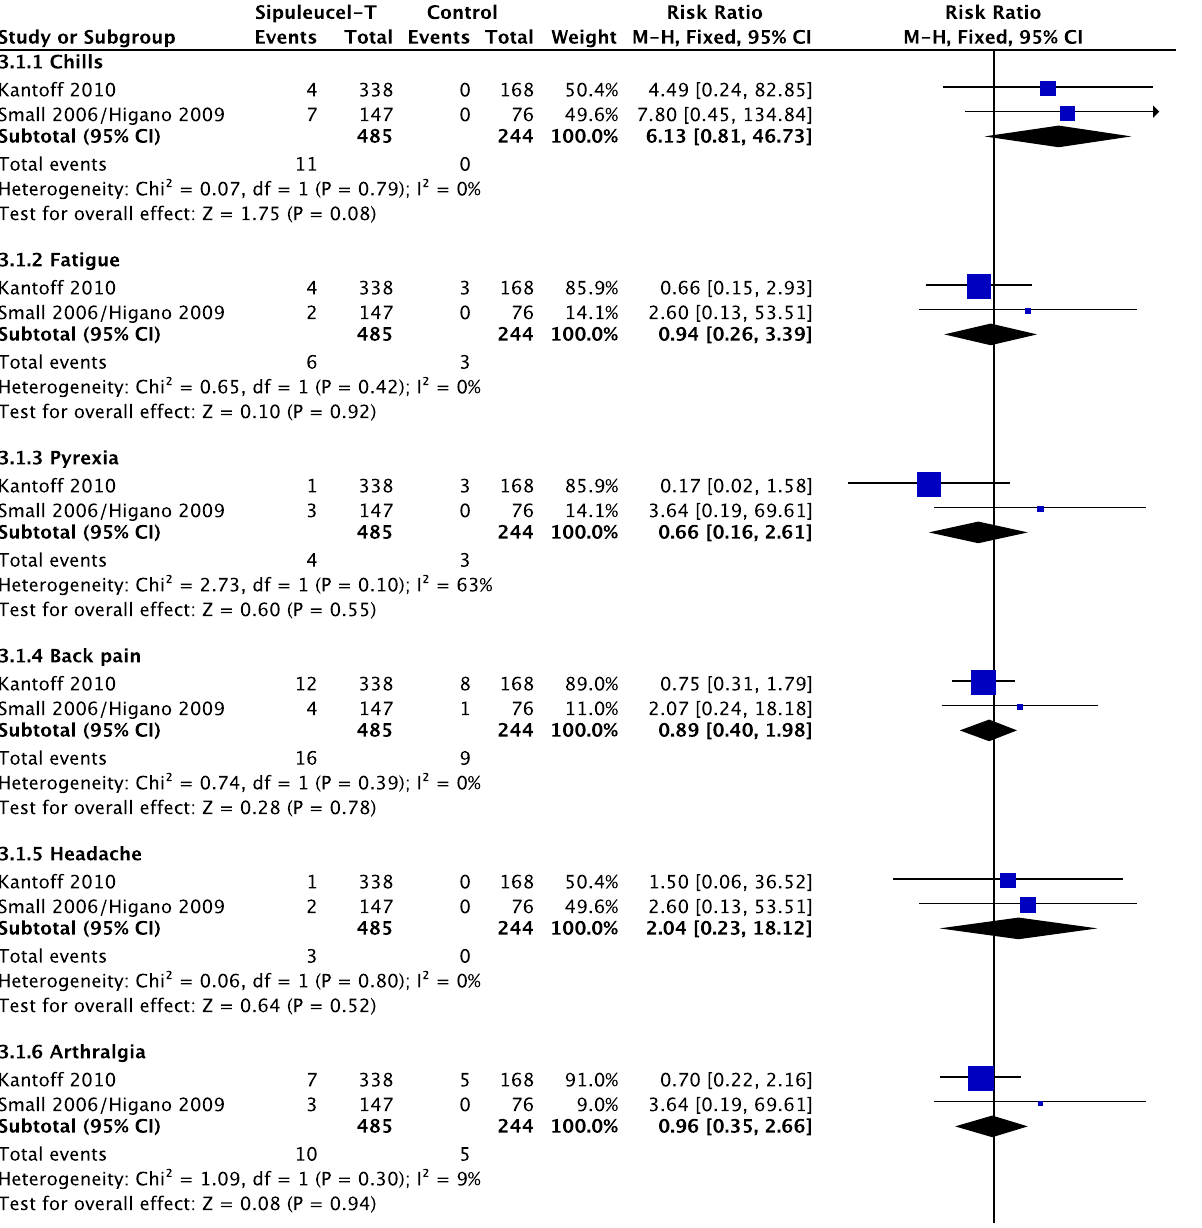
to 2.66), asthenia (RR = 1.49; CI 95% = 0.30